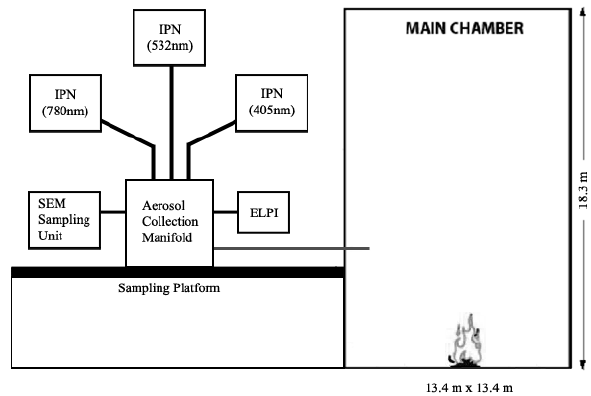
Fig. 1. Schematic diagram of the experimental setup used for smol- Figure 1 dering combustion and characterization of emitted particles.